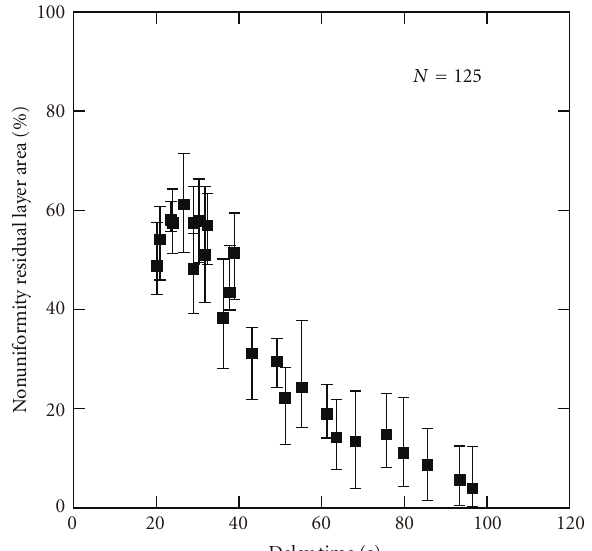
Figure 10: Relationship between delay time and nonuniformity of the residual layer: nonuniformity of the residual layer depended on delay time.